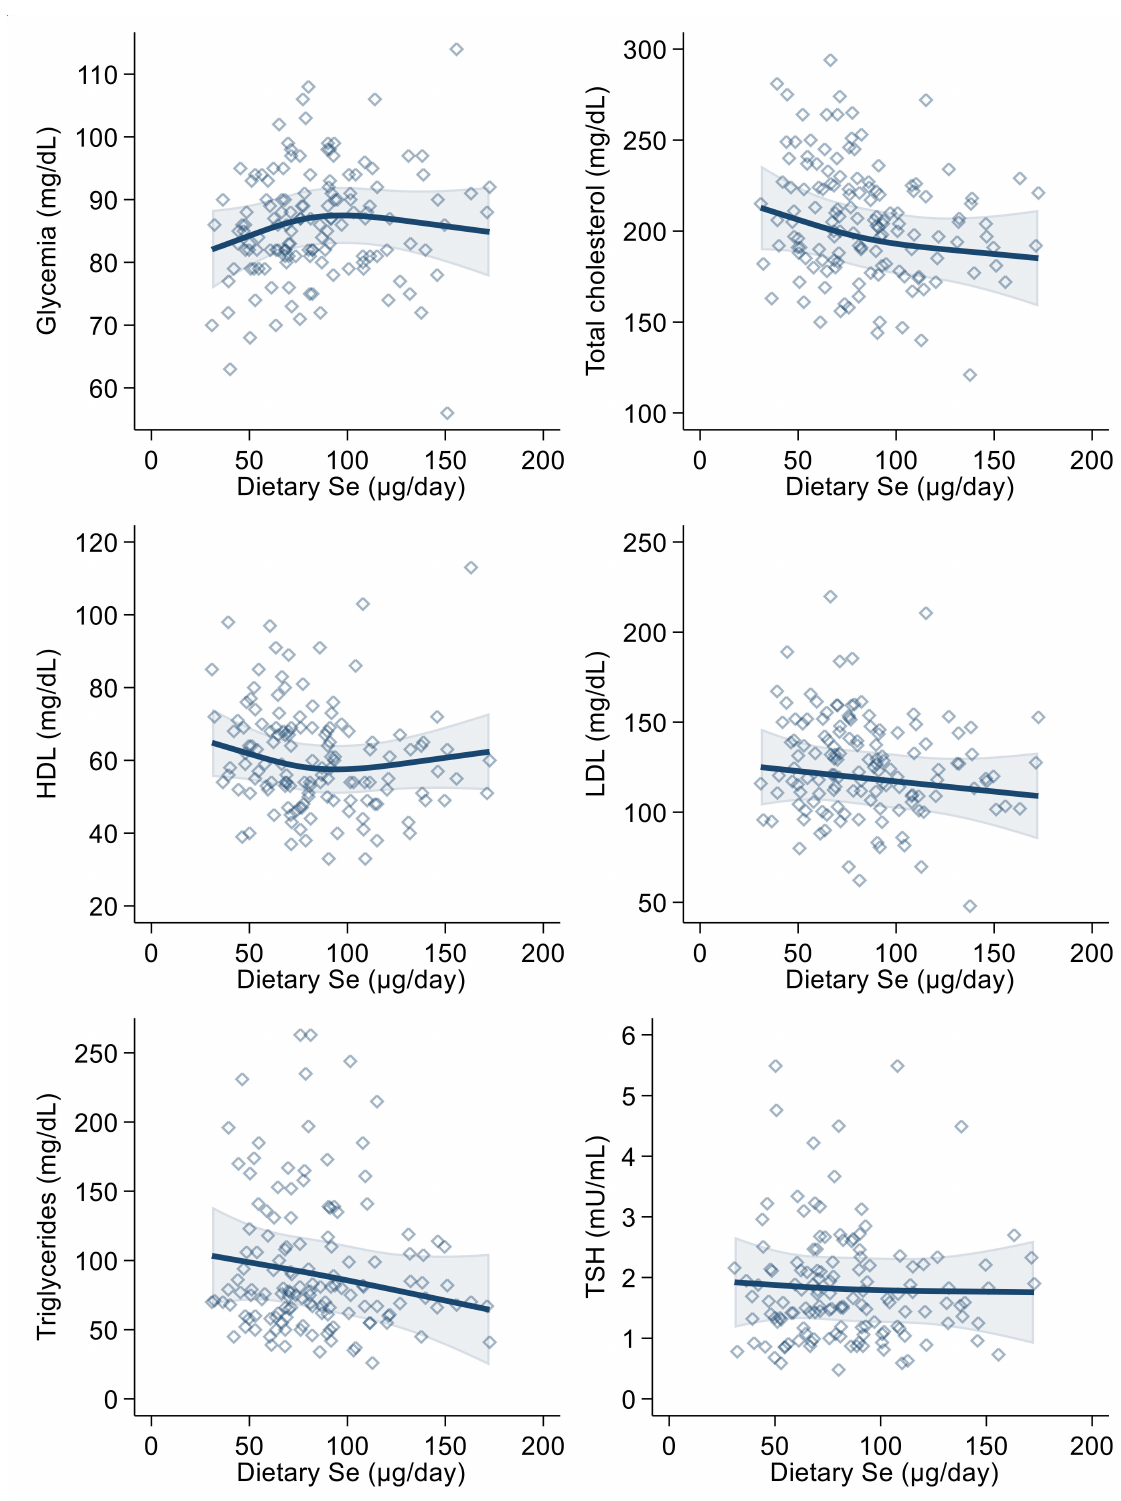
Figure 2. Spline regression analysis of urinary selenium (Se) levels, glycemic and lipid profile variables and thyroid- stimulating hormone (TSH). Solid lines represent multivariable analysis (adjusted for age, sex, body mass index, cotinine levels and alcohol intake) and the shaded area indicates upper and lower confidence interval